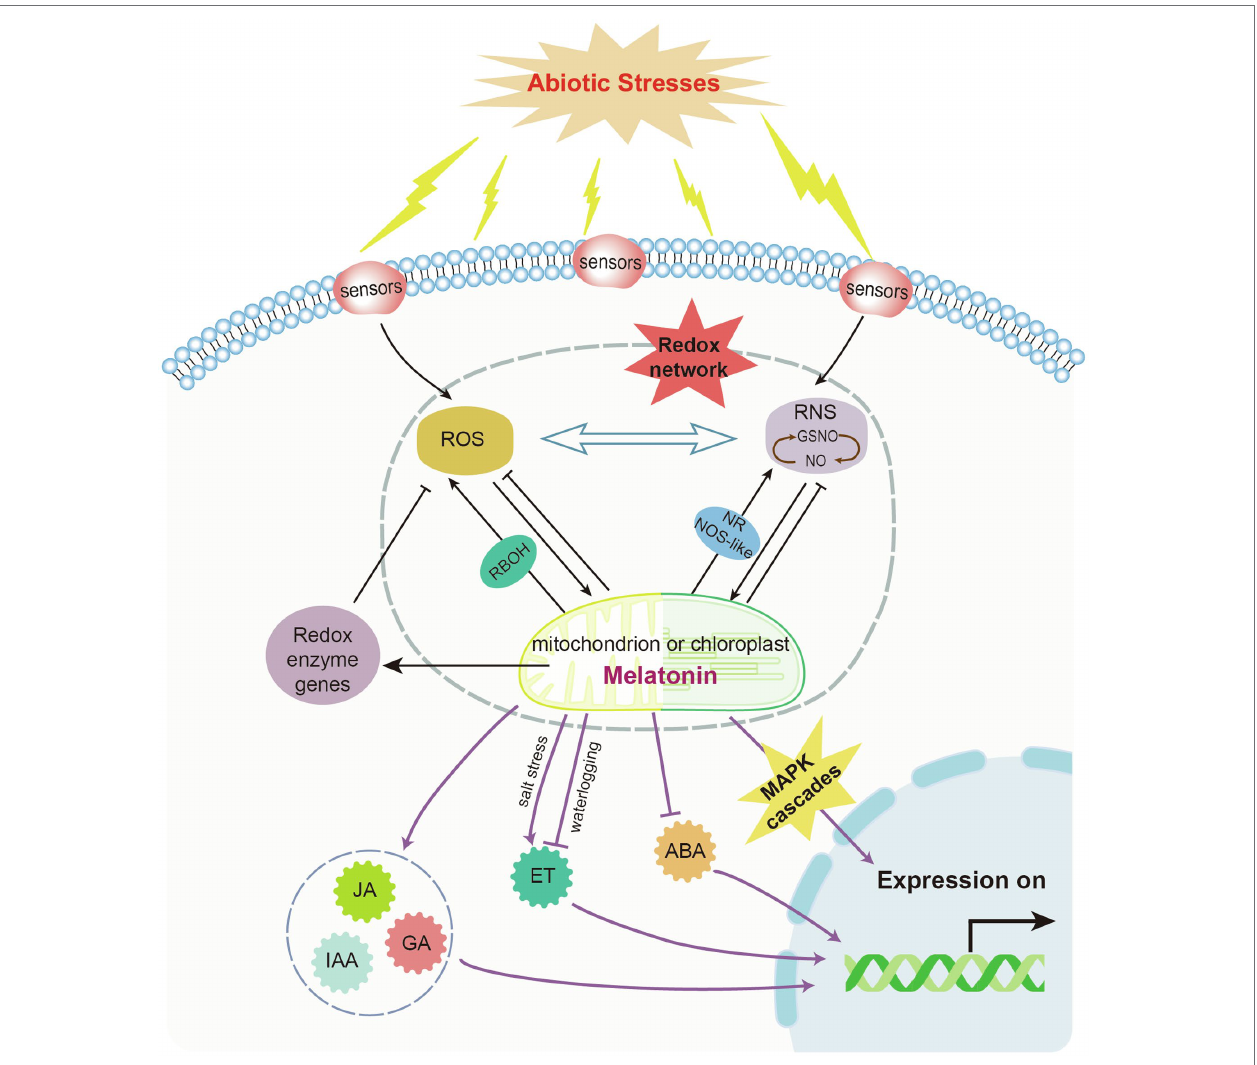
FIGURE 3 | Endogenous melatonin-modulated feedback mechanism in plants under abiotic stresses. Abiotic stresses induce the accumulation of reactive oxygen species (ROS) and reactive nitrogen species (RNS), thus triggering the biosynthesis of endogenous melatonin. RNS and ROS can be scavenged by plant melatonin. Their levels can also be controlled by melatonin-mediated induction of redox enzymes. Mitogen-activated protein kinase (MAPK) cascades and other phytohormone signals are involved in melatonin-modulated transcriptional feedback mechanisms under abiotic stresses. NOS, nitric oxide synthase; GSNO, S-nitrosoglutathione; and RBOH, respiratory burst oxidase